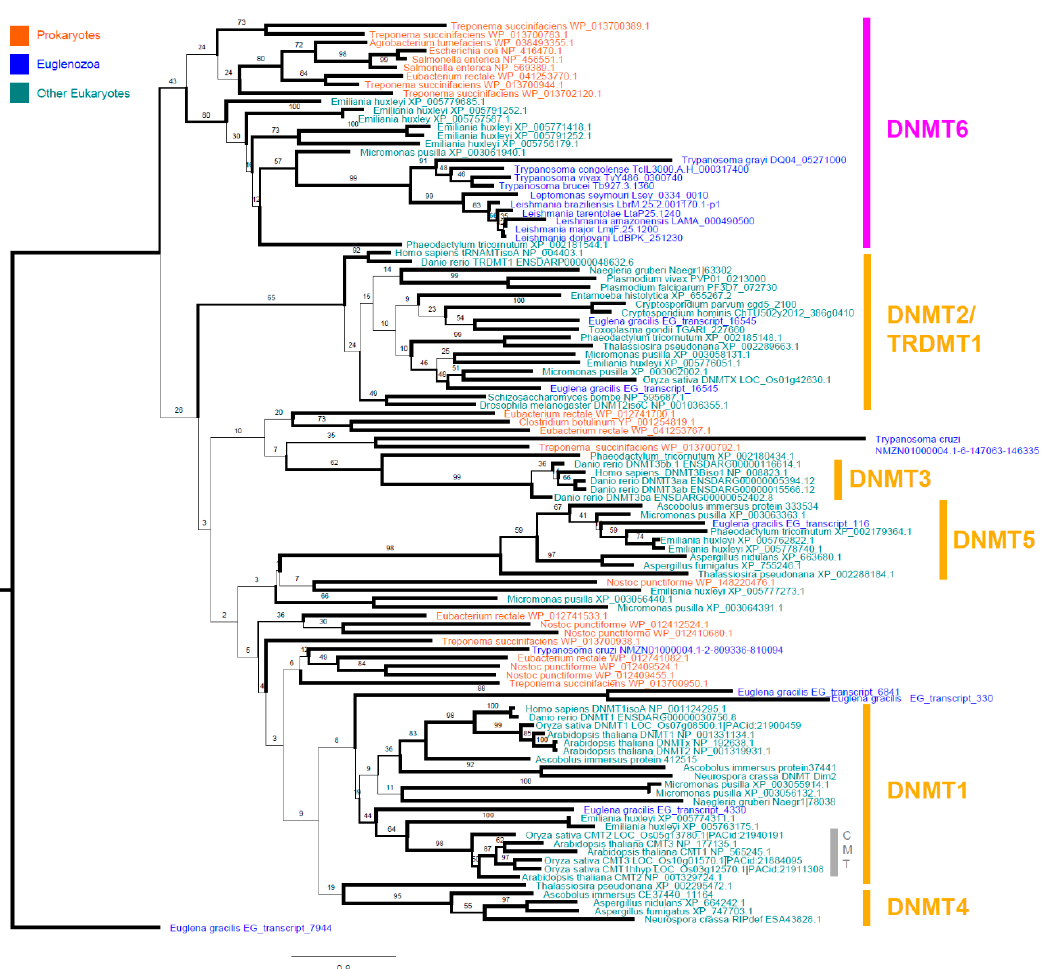
Figure 2. RAxML maximum likelihood tree showing the position of trypanosomatid DNMT (DNMT 6) within the DNMT family. Displayed branch bootstrap values are based on 1000 bootstraps. Line thickness is scaled for these bootstrap values.